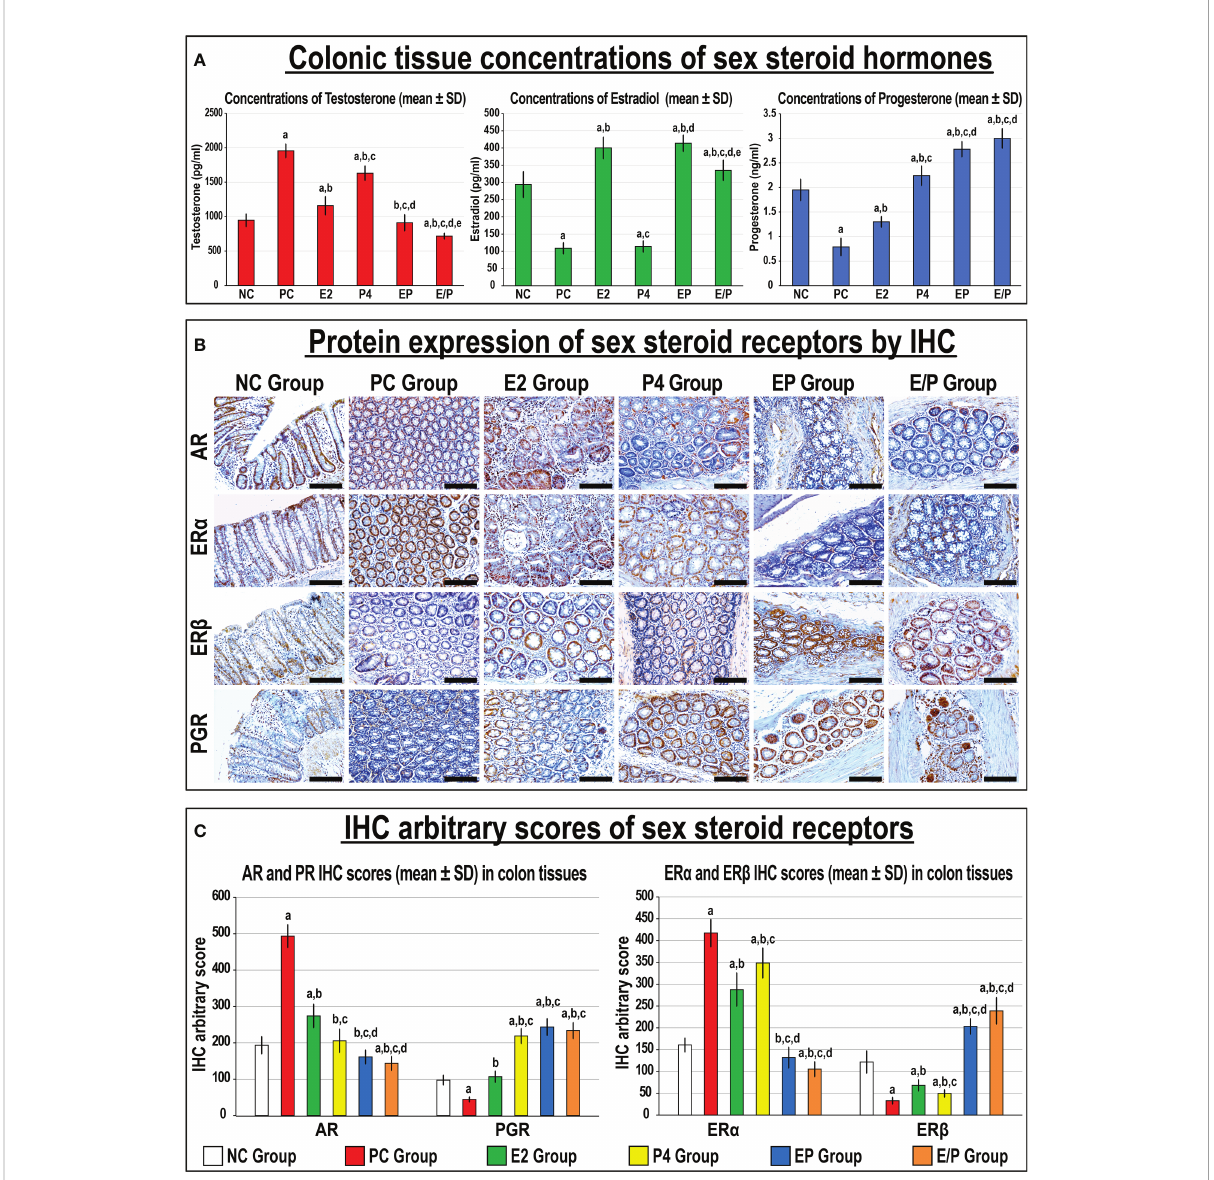
FIGURE 8 (A) Concentrations of testosterone, 17 b -oestradiol, and progesterone hormones with (B) localisation of androgen (AR), progesterone (PGR) and oestrogen (ER) a and b receptors by immunohistochemistry (IHC) in male mouse colonic tissues from all the study groups (20× objective; Scale bar = 15 m m) and (C) the IHC arbitrary scores from the different groups are shown as graph bars (mean ± SD; a P< 0.05 compared with the NC group; b P< 0.05 compared with the PC group; c P< 0.05 compared with E2 monotherapy; d P< 0.05 compared with P4 monotherapy and e P< 0.05 compared with EP concurrent dual therapy